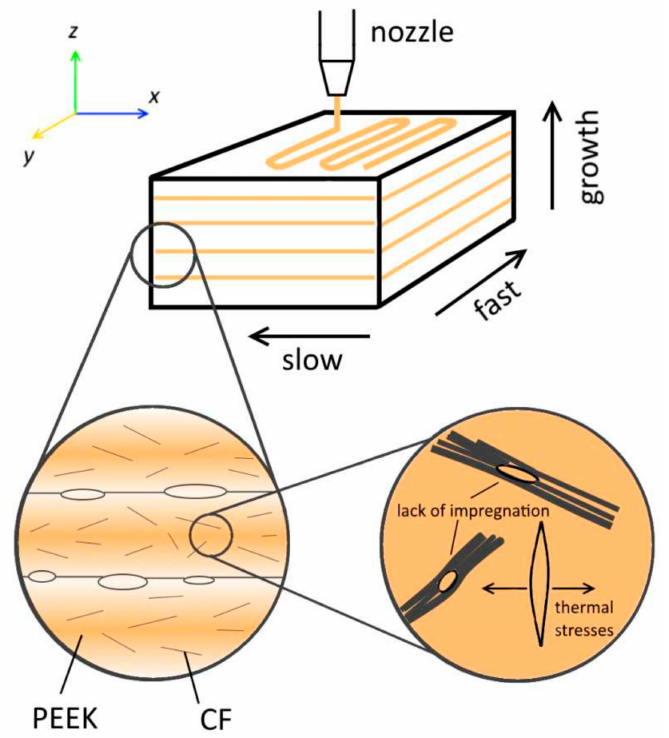
Figure 15. Schematic diagram for 3D printed CF-PEEK composites. Reprinted with permission from [107]. Copyright 2018 Elsevier